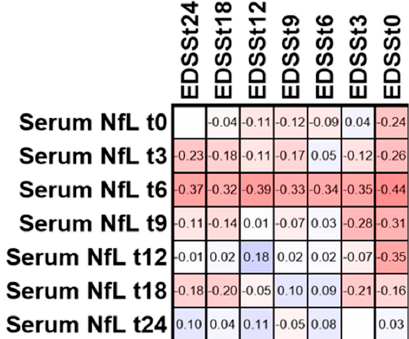
Figure 5. Correlation matrix of Spearman correlation analysis for serum NfL and EDSS. Numbers in the cells are showing the respective Spearman correlation coefficient.